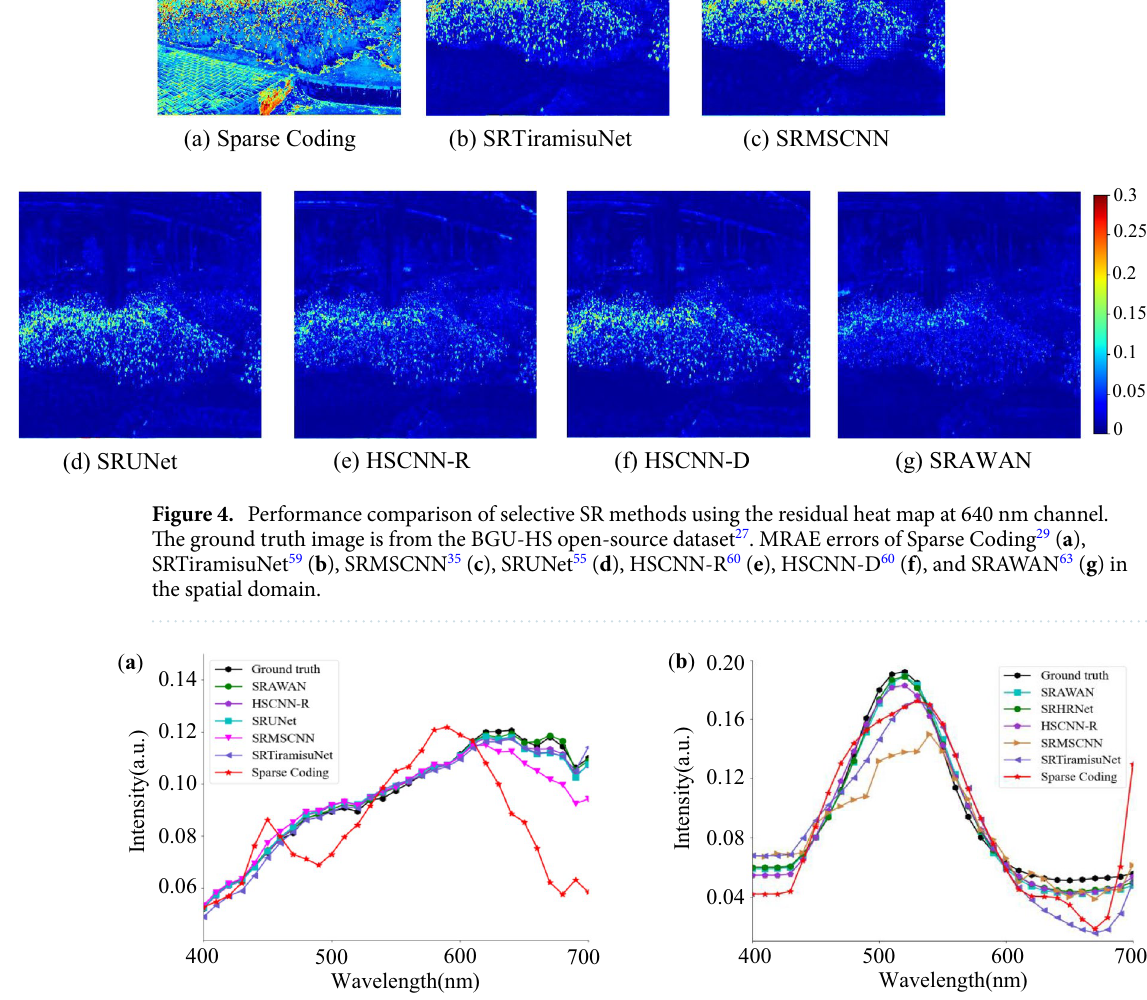
Figure 5. Spectral error comparison of SR methods on selected spatial locations. Data from BGU-HS ( a ) and ARAD-HS ( b